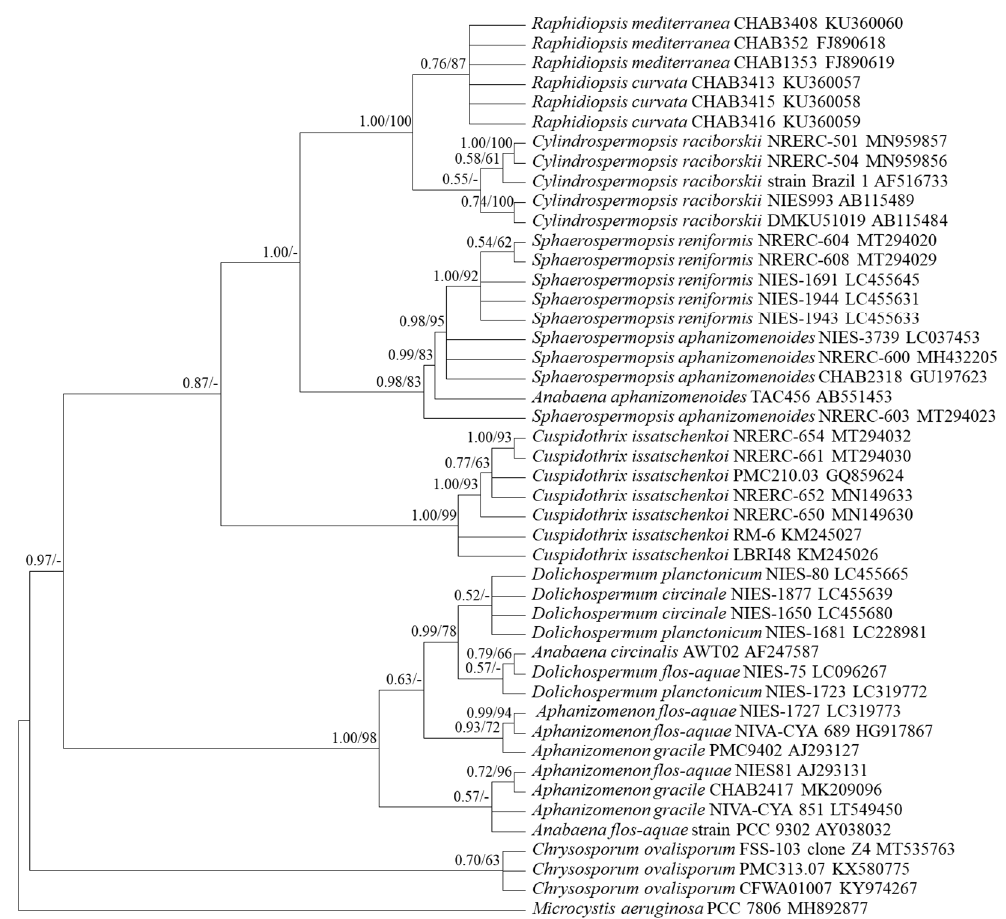
Figure 1. Consensus Bayesian tree based on aligned 1006-bp sequences of the 16S rRNA using the GTR+G+I model with Microcystis aeruginosa as an outgroup. The parameters were as follows: assumed equal nucleotide frequency; substitution rate matrix with A–C substitutions = 0.0928, A–G = 0.2562, A–T = 0.0772, C–G = 0.0801, C–T = 0.4256, and G–T = 0.0678; proportion of sites assumed to be invariable = 0.5723; and rates for variable sites assumed to follow a gamma distribution with the shape parameter = 0.2774. The branch lengths are proportional to the amount of character changes. The numbers above the branches indicate the Bayesian posterior probability ( left ) and maximum-likelihood bootstrap values ( right ). Posterior probabilities ≥ 0.5 are shown.